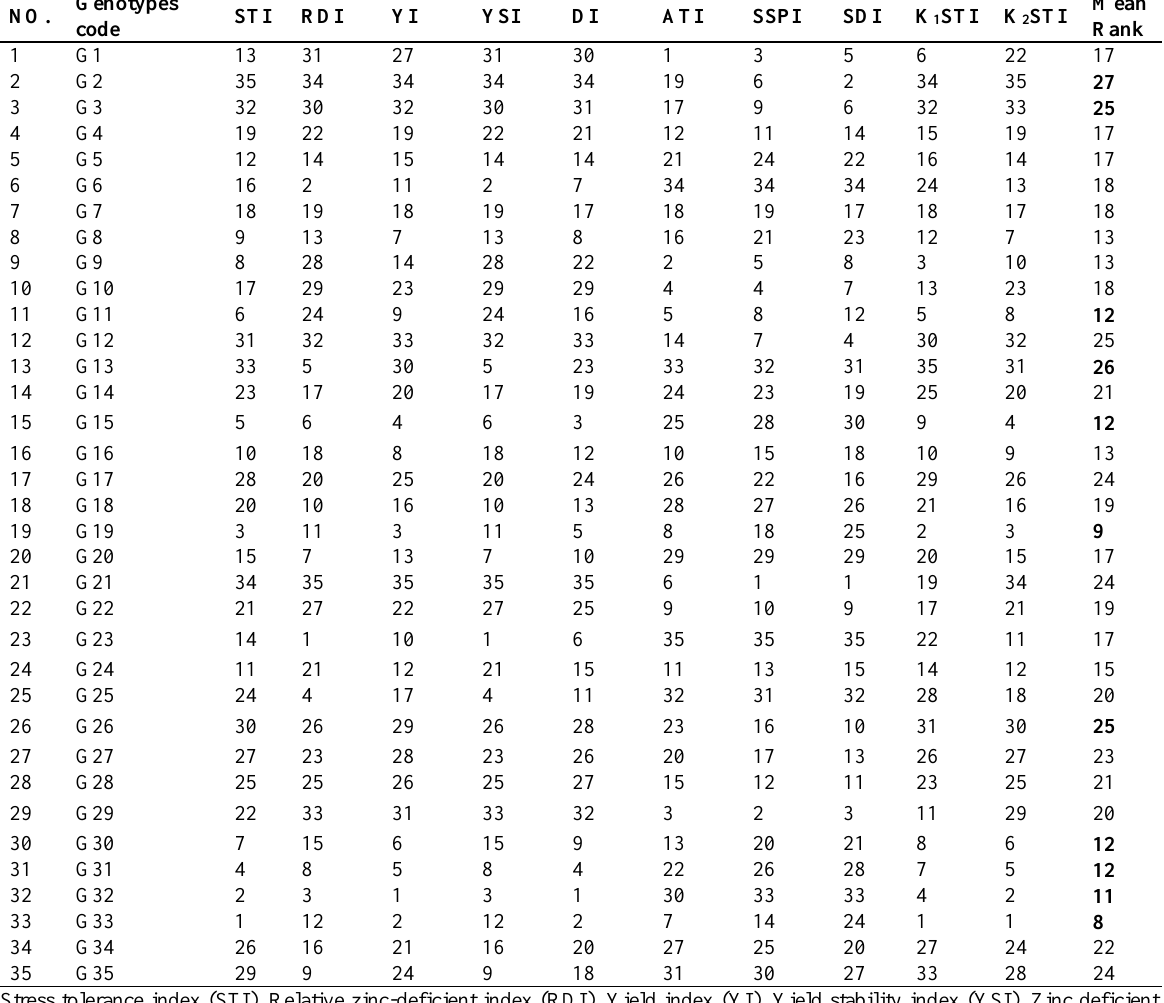
Table 5. The rank of STI and new indices of zinc stress tolerance for 35 durum wheat